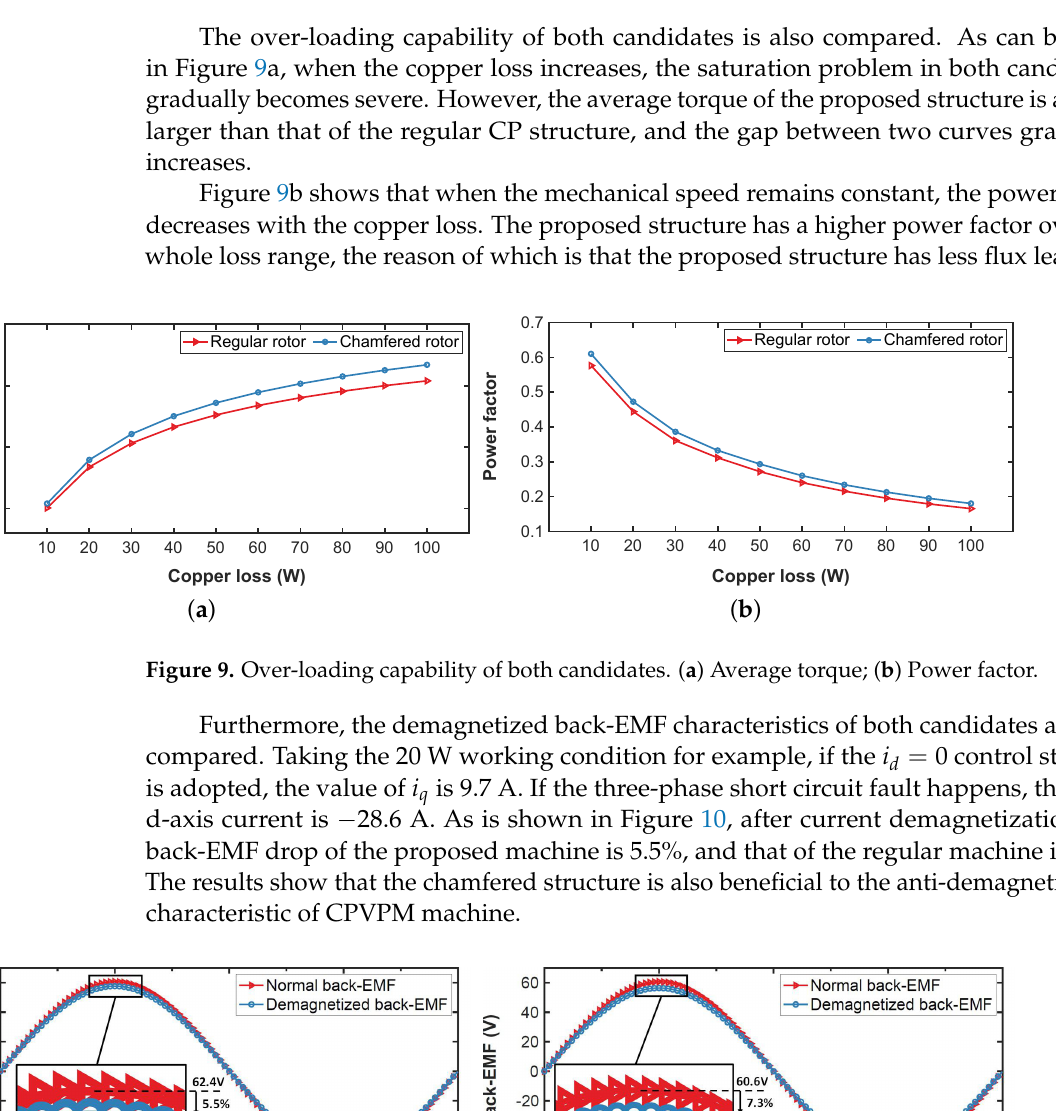
Figure 8. Torque performances of both candidates. ( a ) Torque; ( b ) Cogging torque.